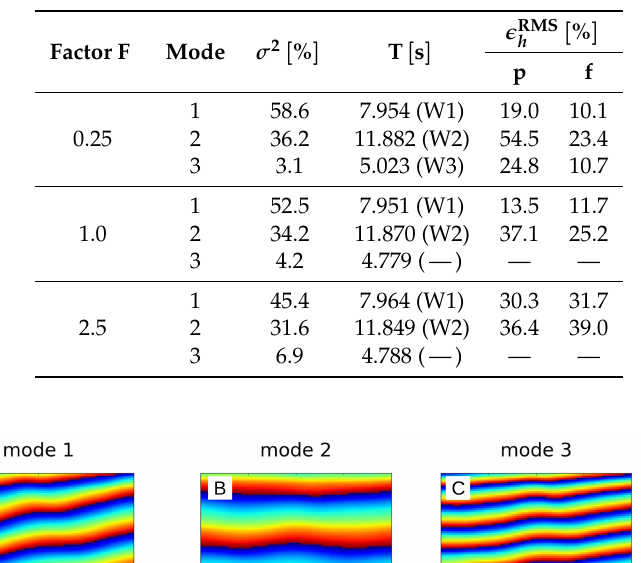
Table 8. Summary of the results for nonlinear wave propagation of the polychromatic WS case with different F factors: Relative RMSE, (cid:101) RMS , are given for h (cid:62) 0.75 m. Here, “ p ” and “ f ” stand for phase h and function fitting of the wavenumber. Next to the retrieved period, the corresponding wave field is indicated (when applicable).